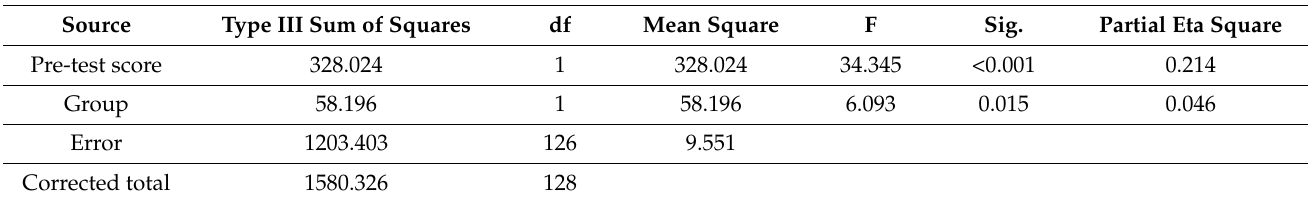
Table 4. The ANCOVA analysis of the post-test score between different health education